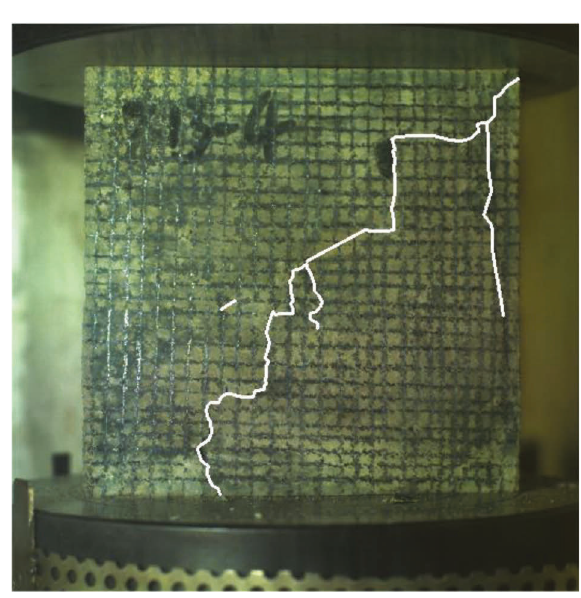
Figure 5: The damaged